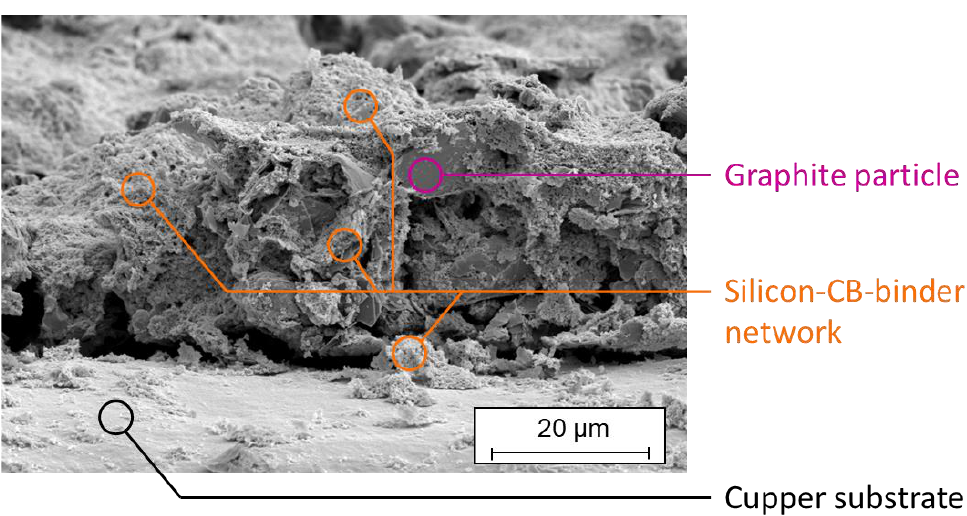
Figure A1. Comparison of resulting carbon black particle size distributions of the reference process and in a one- passage operation of a stirred media mill under variation of the product volume flow V ̇ as well as the stirrer tip speed v t .